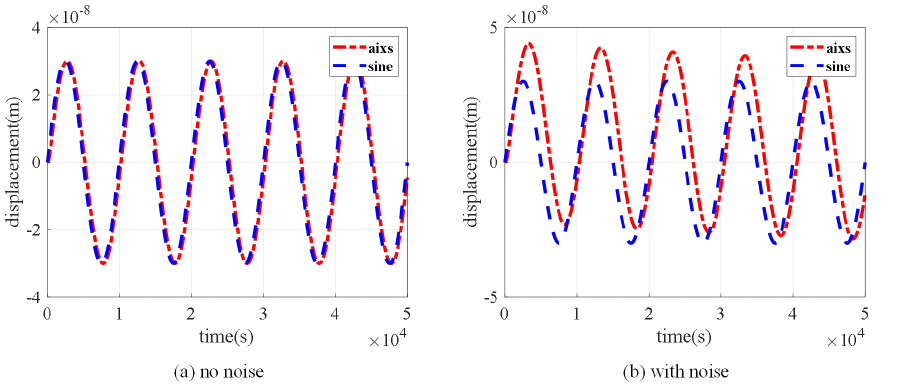
Figure 10. Tracking of drag − free using frequency-domain-based controller ( a ) with noise and ( b ) with no